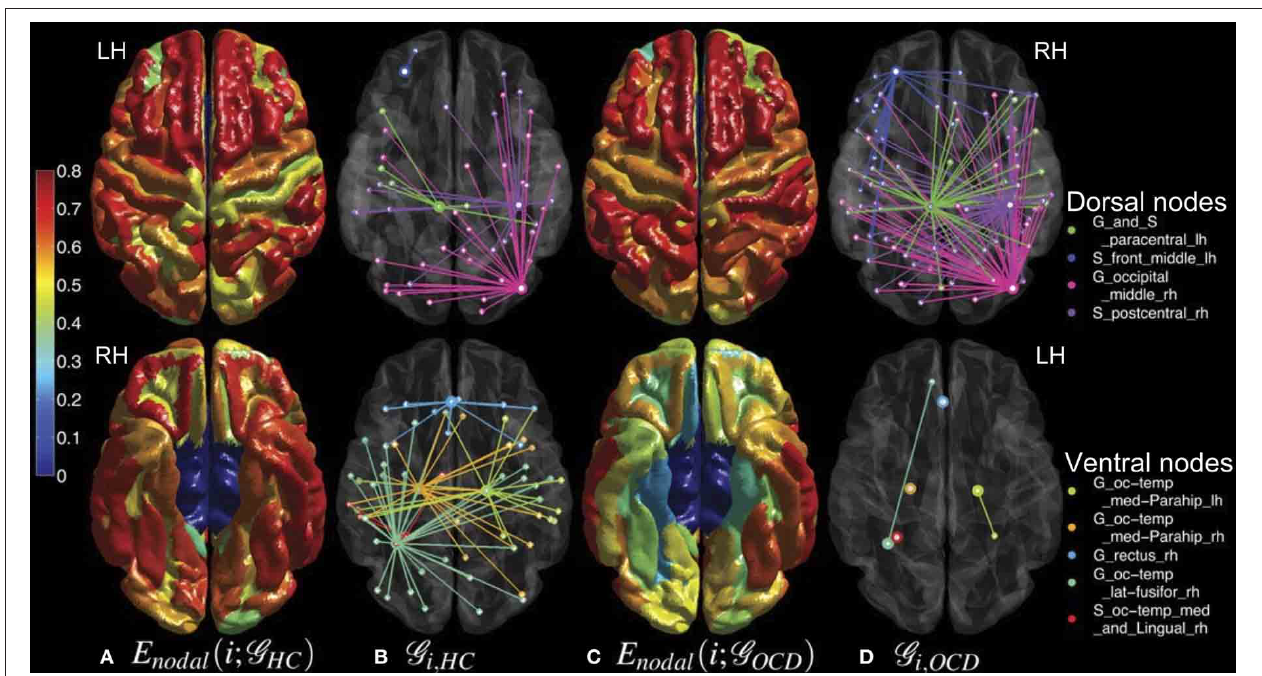
FIGURE 5 | Mean nodal efficiencies across costs are overlaid on the cortical surfaces of the controls (HC, column A) and the OCD patients (OCD, column C) from a dorsal view (upper row) and a ventral view (lower row). See the color bar on the leftmost side for the color coding from 0 to 0.8. The sub-graphs ( G i ) of the binary